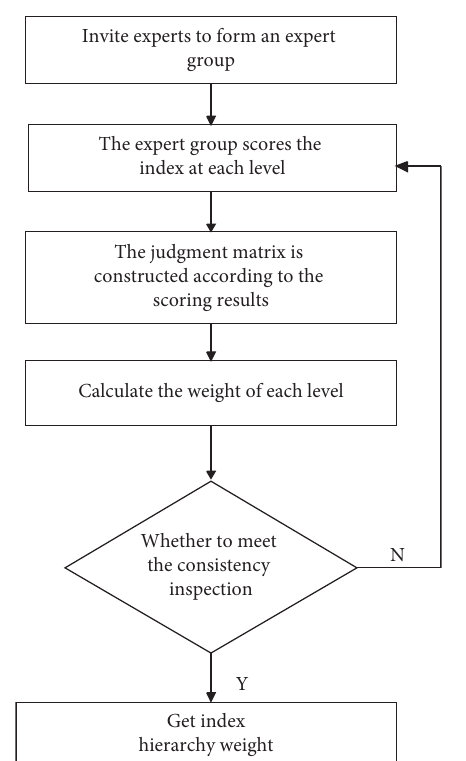
Figure 2: Flow chart of determining hierarchy weight by improved AHP.